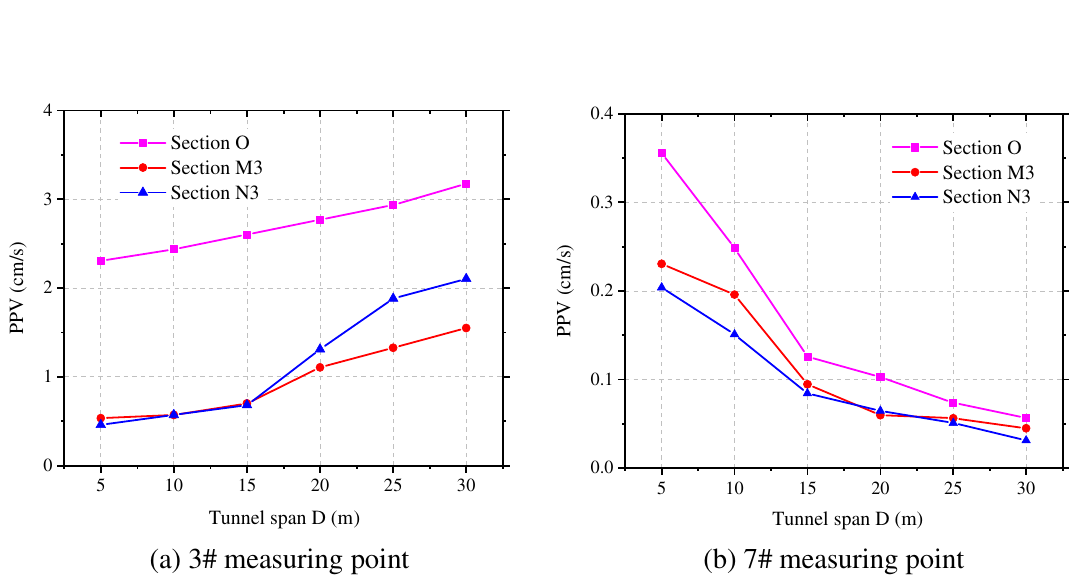
Figure 13. Radial PPV evolution of measuring points 3# and 7# at different tunnel